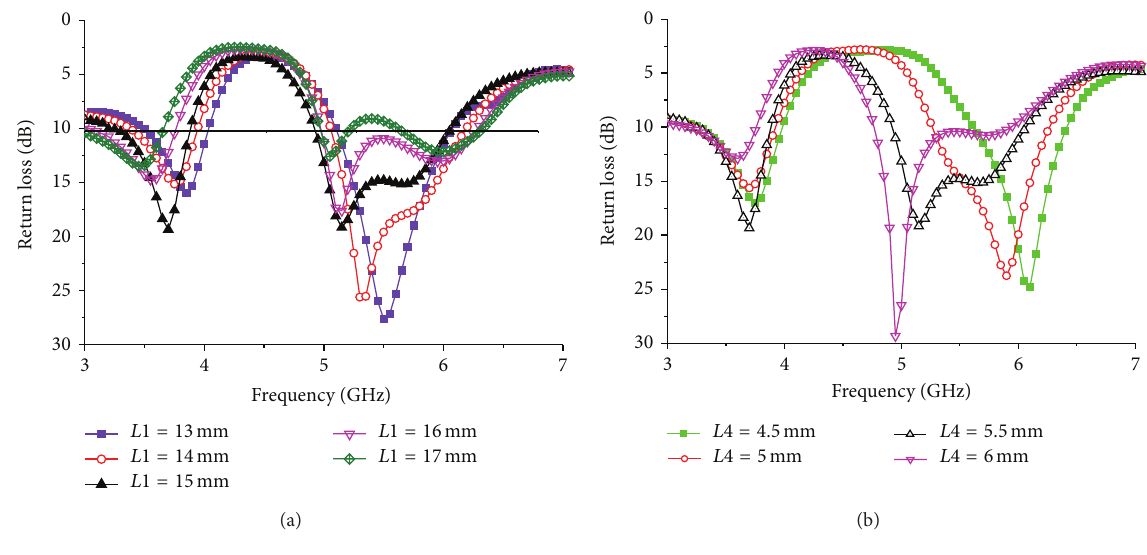
Figure 5: Parametric studies of symmetric slit long (a) 𝐿1 (b) 𝐿4 .